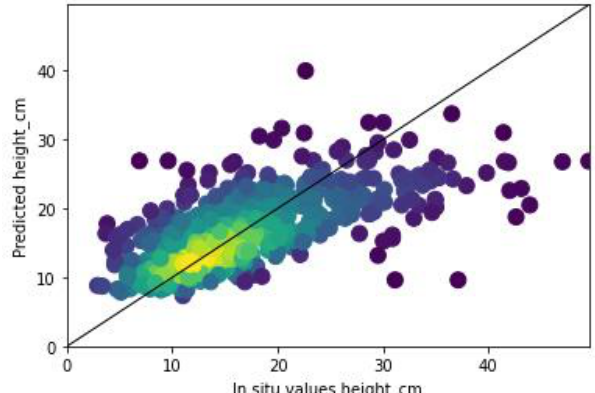
Figure 5: Scatter plot of predicted vs. in situ vegetation height in grasslands.